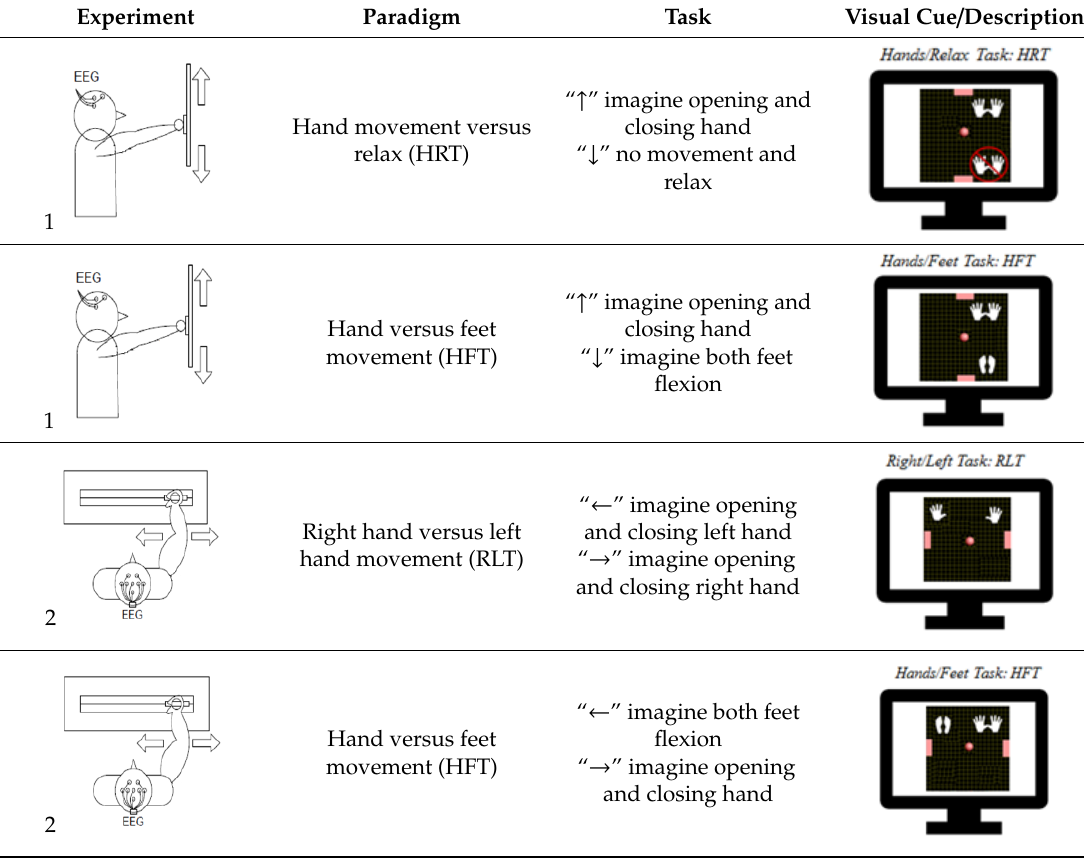
Table 3. BCI tasks.